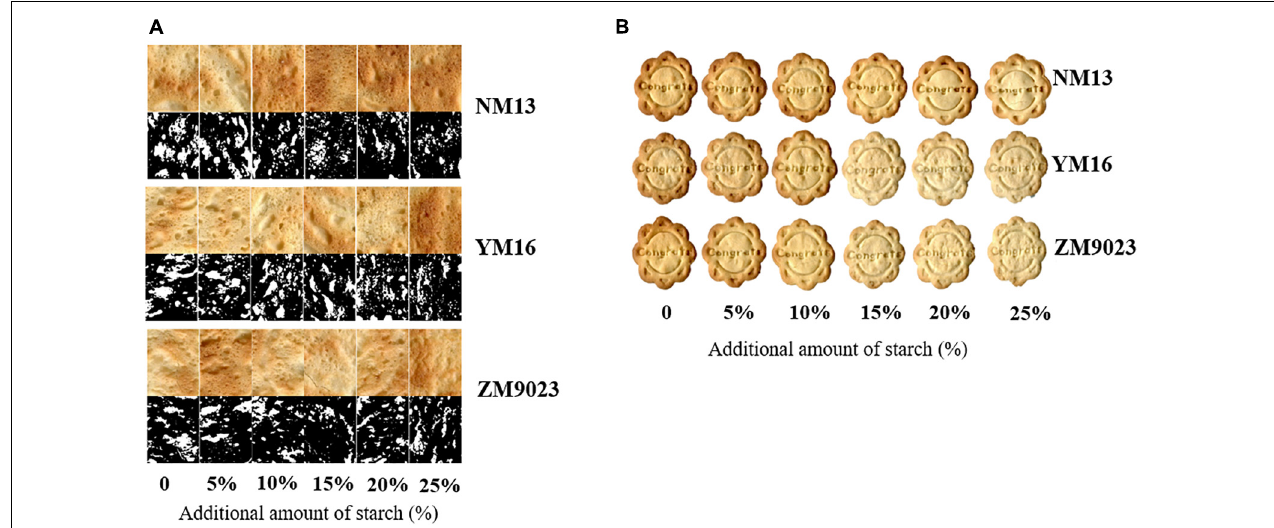
FIGURE 3 | Appearance of short biscuits (A) and image of the bottom side of biscuit (B) . NM13, YM16, and ZM9023 indicate Ningmai 13, Yangmai 16, and Zhengmai 9023, respectively. In left figure (B) , the first, third and fifth lines were view of bottom side of biscuit, and second, fourth and sixth lines were binary images of